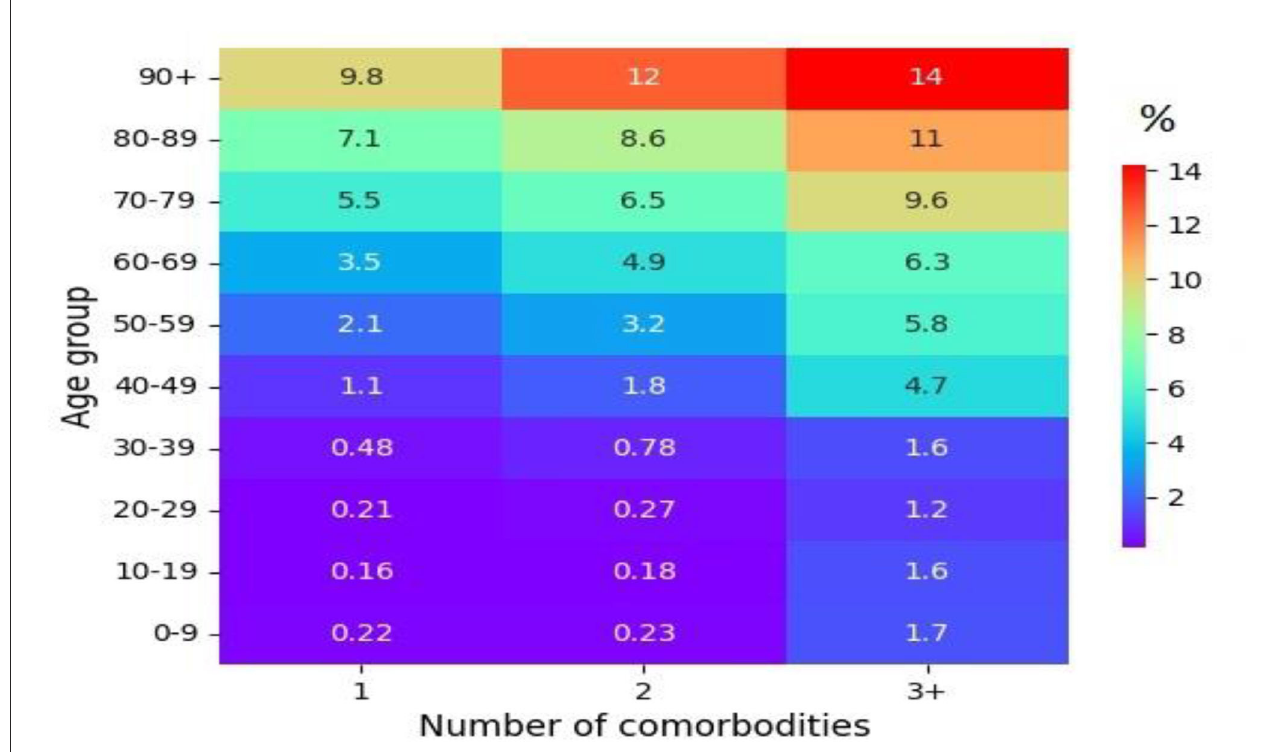
FIGURE4 The proportion (%) of fatal outcomes in cases of a COVID-19 infection by age groups and the number of comorbidities.